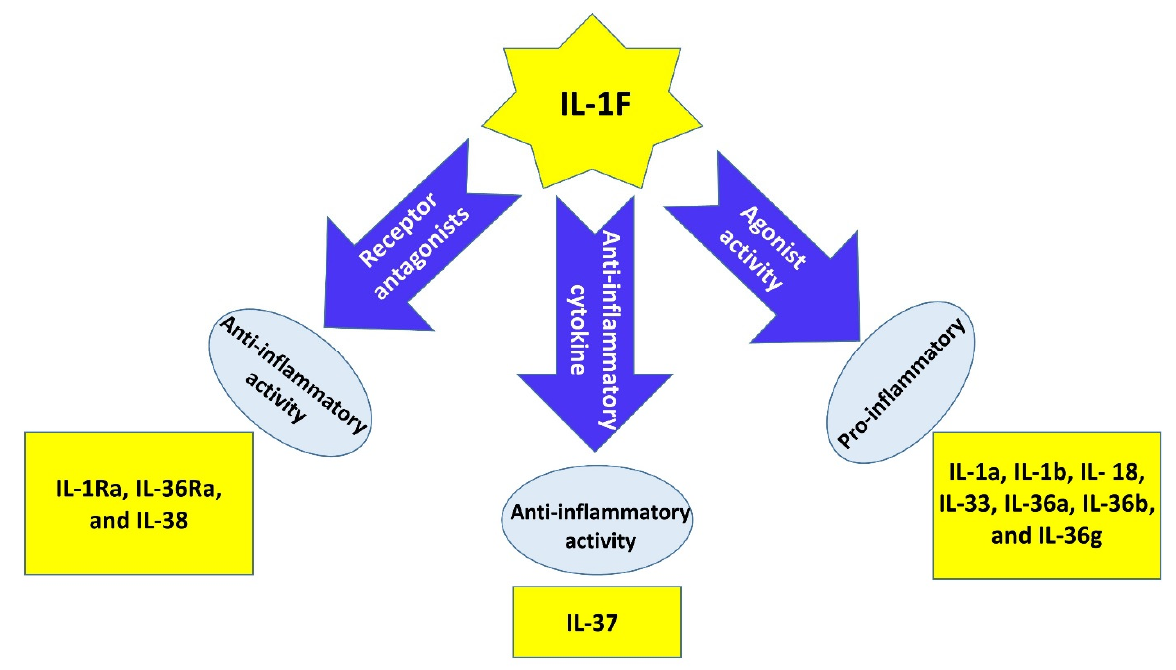
Figure 3. Subtypes of the IL-1 family and their different functions. Created by Esmaeilzadeh et al. The immune functions of members of the IL-1 superfamily depend on their receptor.